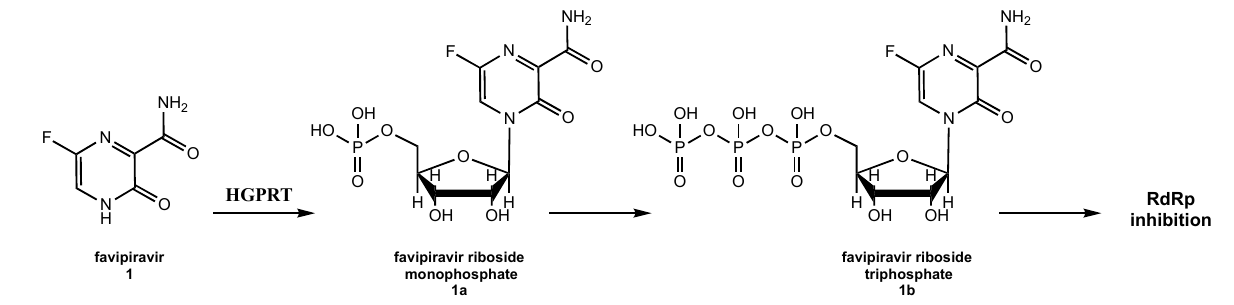
Figure 2. Mechanism of action of favipiravir.